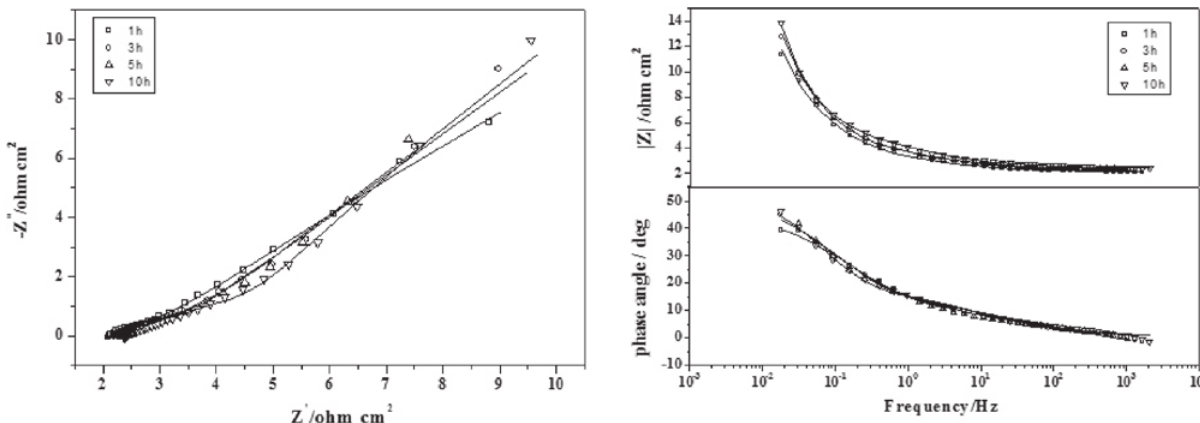
Fig. 2: Nyquist and Bode plots for the corrosion of porous Cu-35mass%Ni-5mass%Cr in molten (0.62Li,0.38K) 2 CO 3 at 650 °C in air for 1, 3, 5, 10 h, respectively. Symbol: experimental data and line: fitted data